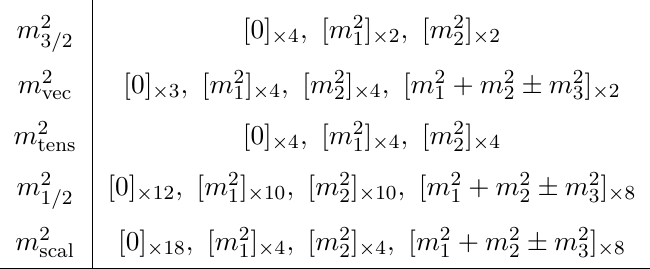
Table 19 . Masses for the Minkowski vacuum